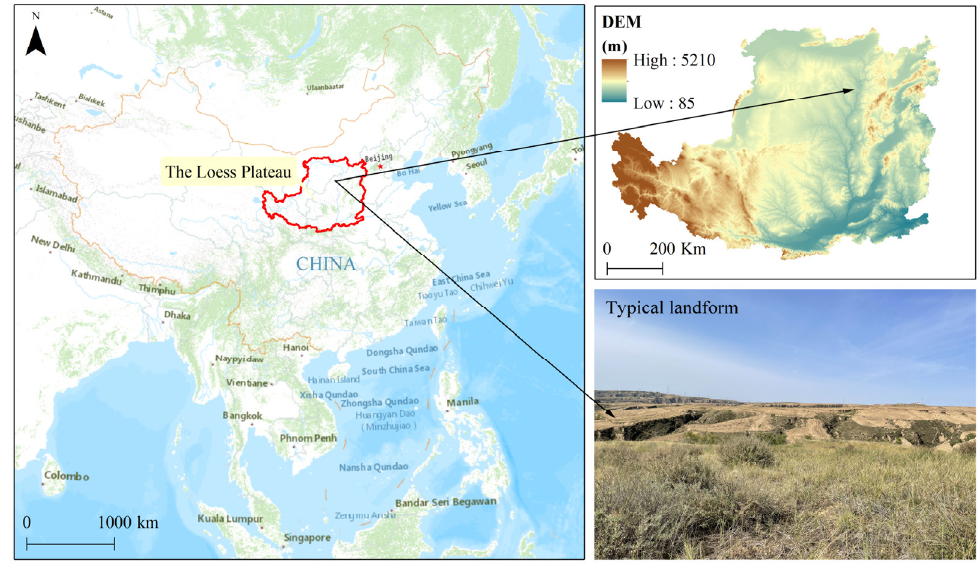
Figure 1. Study area.